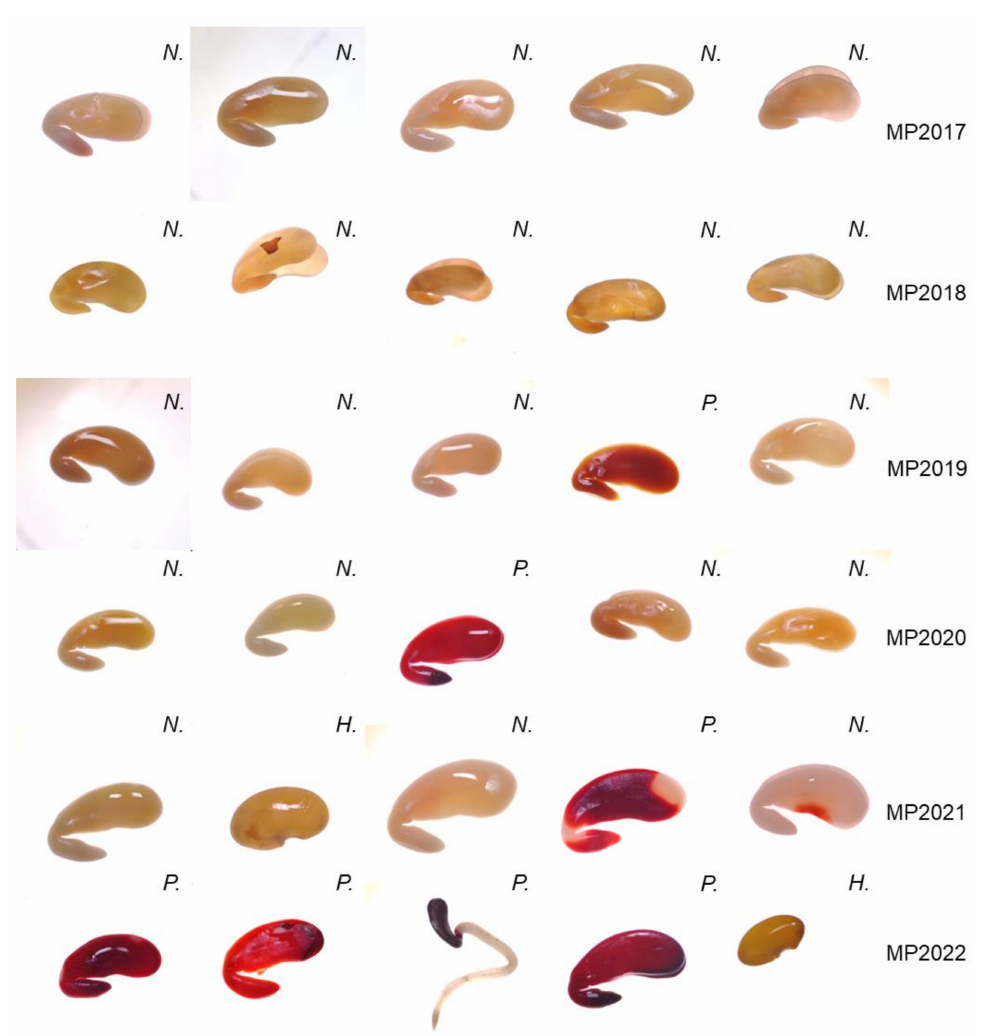
Figure 6. Viability test of M. polymorpha by TTC. The seeds of M. polymorpha that were more than two years old did not have significant viability, and, golden cauliflower has a certain hard-solid rate. The seeds with viability are labeled as P ; the seeds without viability are labeled as N ; and the hard-solid seeds are labeled as H